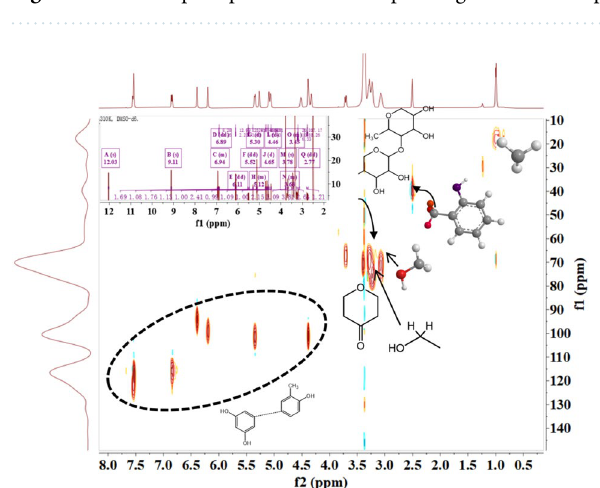
Figure 4. LC–MS peak pattern and corresponding LC-MS 2 M/Z pattern.